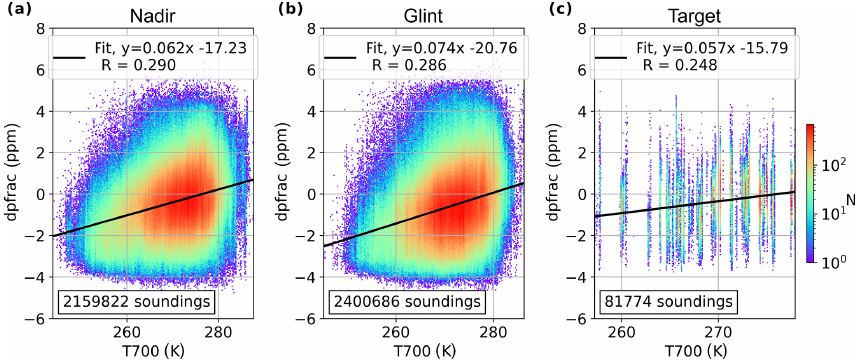
Figure 12. Correlations and linear regressions for dpfrac (defined in the Supplement or by Kiel et al., 2019) as a function of temperature at 700hPa (T700) for all retrievals over land north of 50 ◦ N that pass boreal QC and separated here by viewing